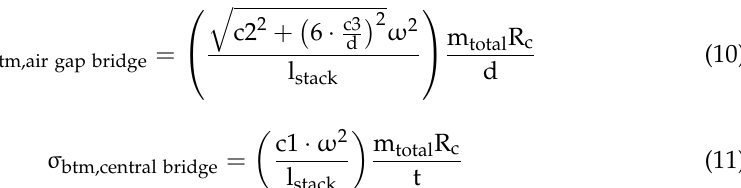
Figure 6c [18,22]. Average mechanical stresses at the air gap bridges σ btm,air gap bridge and central bridges σ btm,central bridge are given